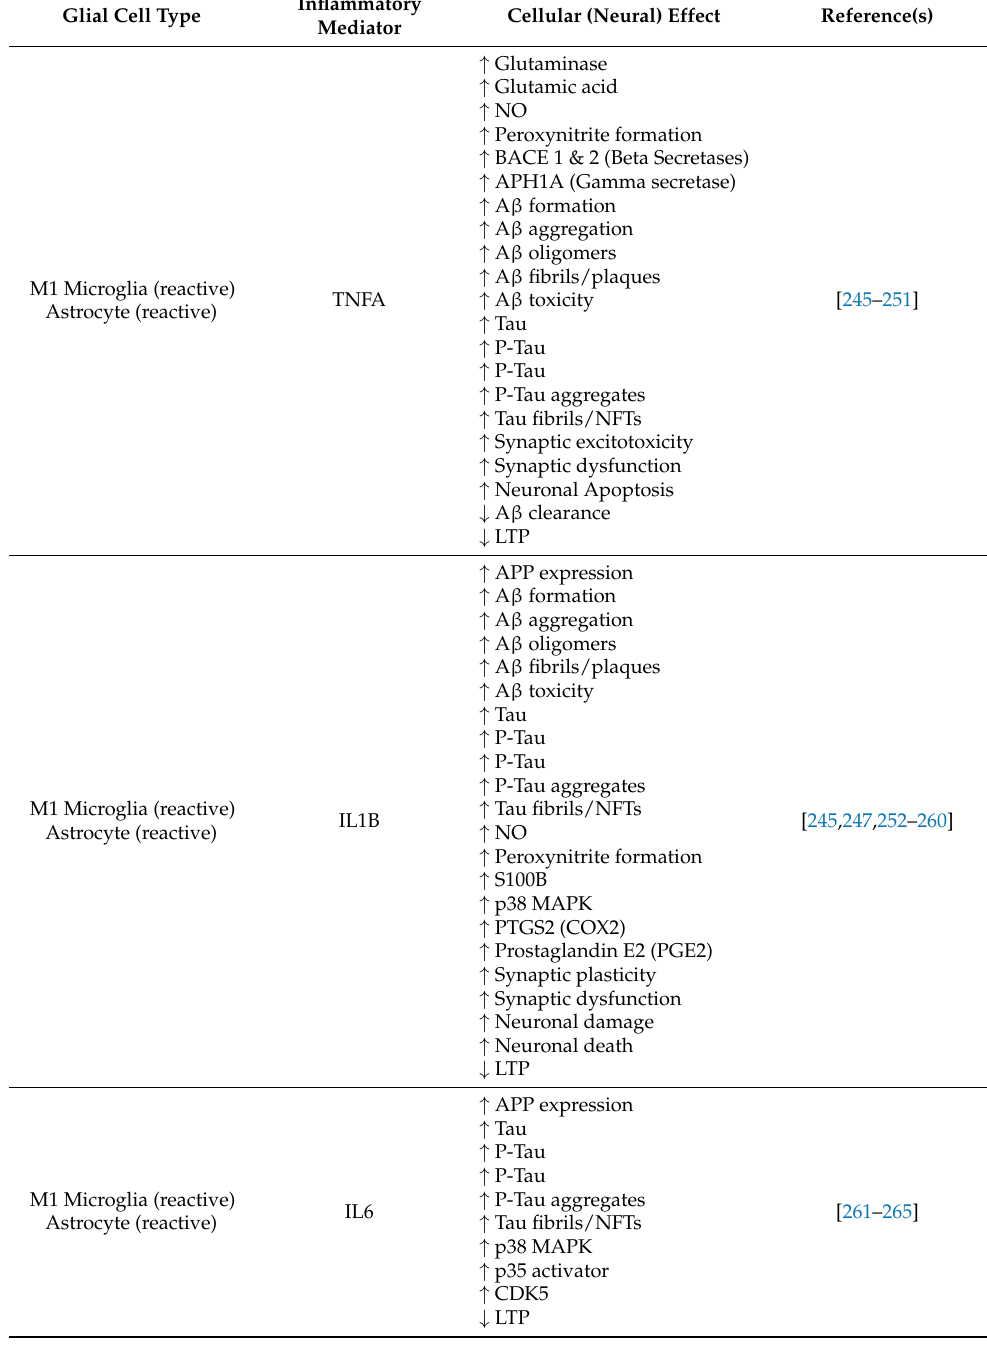
Table 3. Glial inflammatory mediators associated with Alzheimer’s